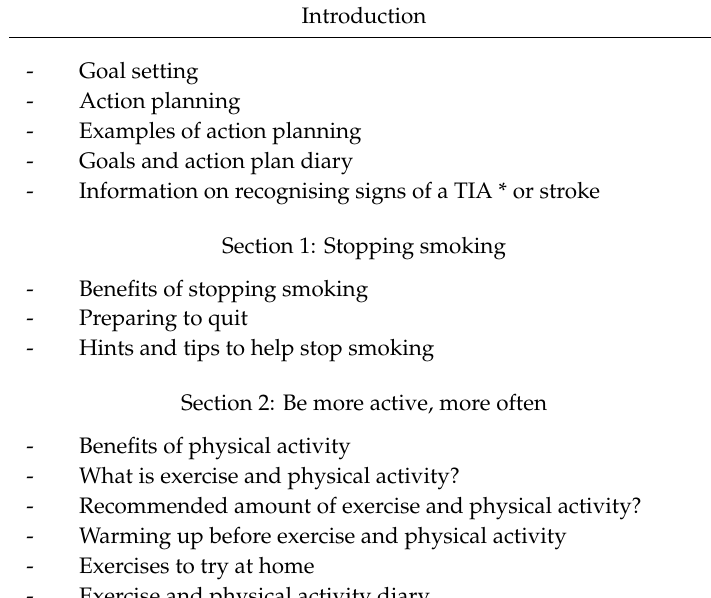
Table 1. Core components of “The Healthy Brain Rehabilitation Manual”.